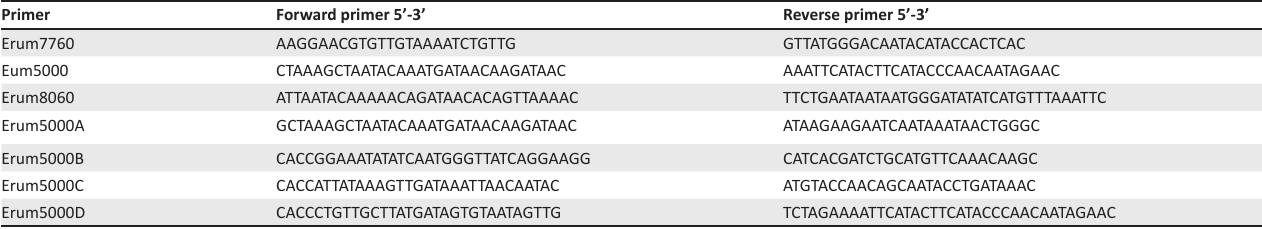
TABLE 1-A1: Primer sequences used for cloning of three open reading frames into pET vector.